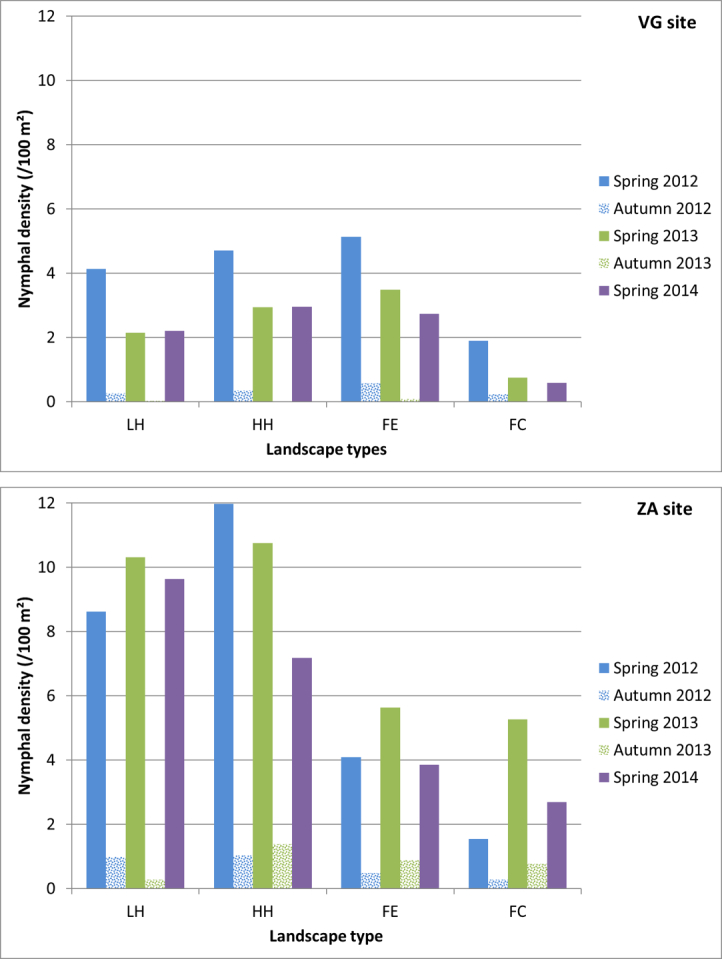
I.
ricinus nymphal density in the two sites (VG and ZA), according to campaign and landscape type.Landscape types:LH: Agricultural landscapes with a Low Hedgerow network densityHH: Agricultural landscapes with a High Hedgerow network densityFE: Forest EdgeFC: Forest Core